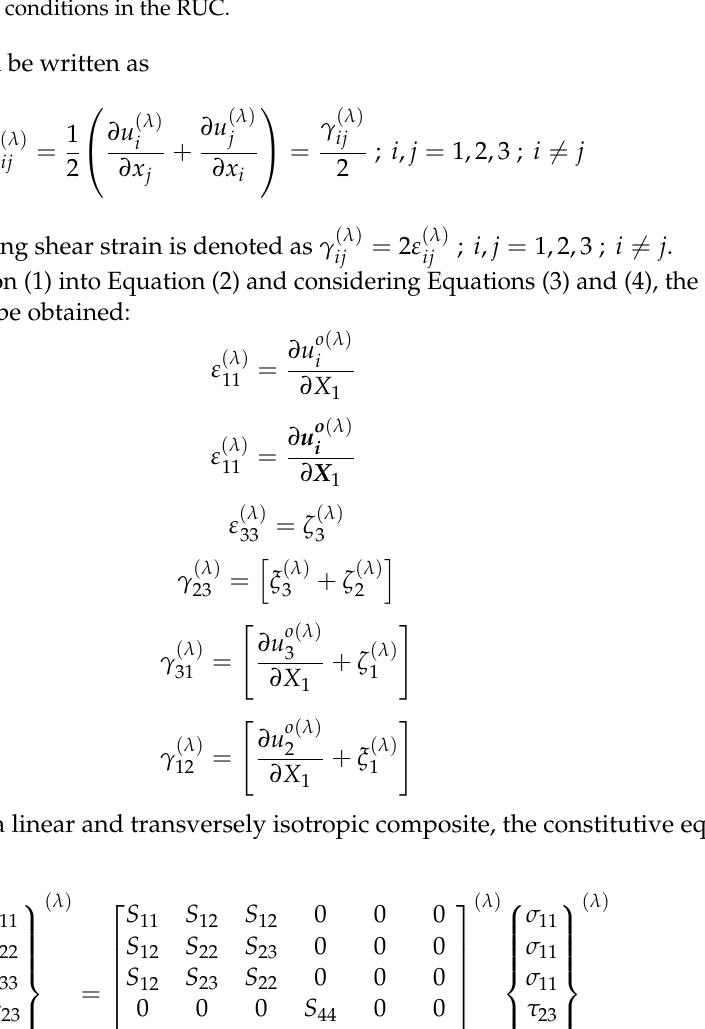
Figure 4. Continuity conditions in the RUC.